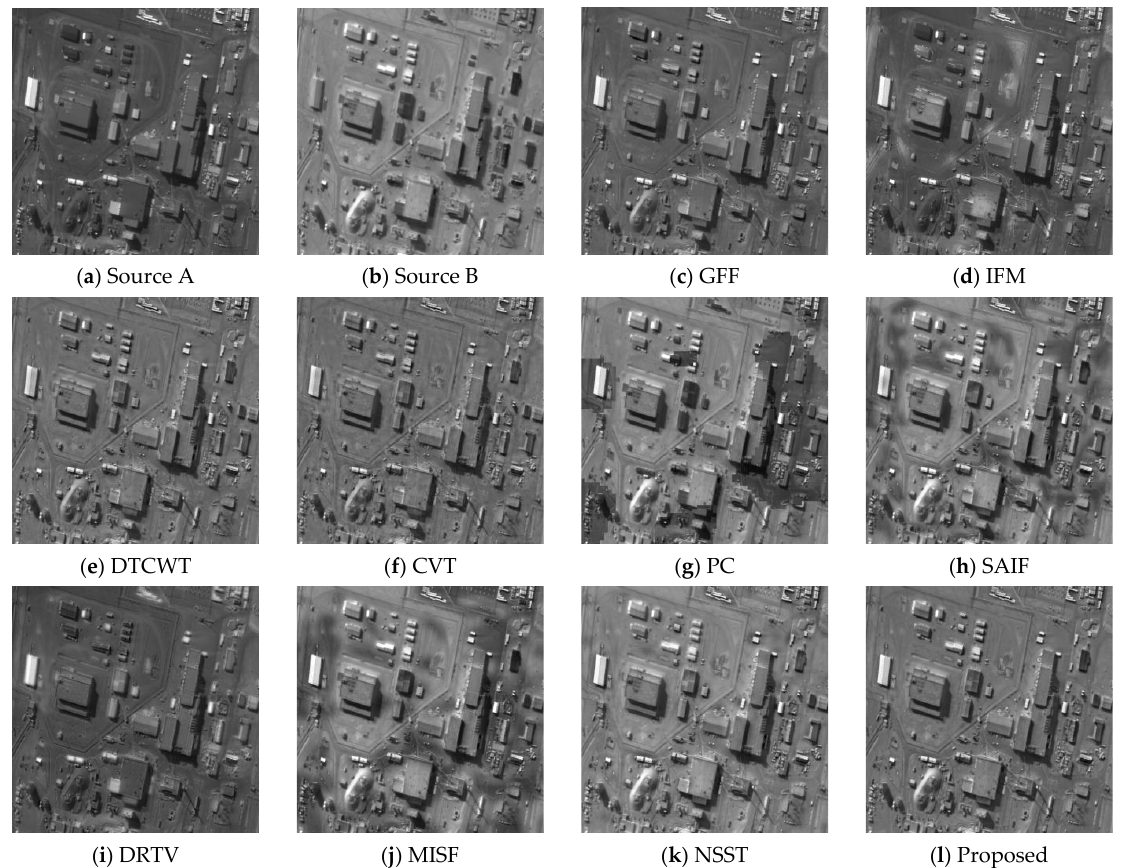
Figure 4. Fusion results of the first group of images. ( a ) Source A, ( b ) Source B, ( c ) guided image filter (GFF), ( d ) image matting for fusion (IFM), ( e ) dual-tree complex wavelet transform (DTCWT), ( f ) curvelet transform-based image fusion (CVT), ( g ) phase congruency (PC), ( h ) structure-aware image fusion (SAIF), ( i ) different resolutions via total variation (DRTV), ( j ) multimodal image seamless fusion (MISF), ( k ) nonsubsampled shearlet transform (NSST), ( l ) proposed method.